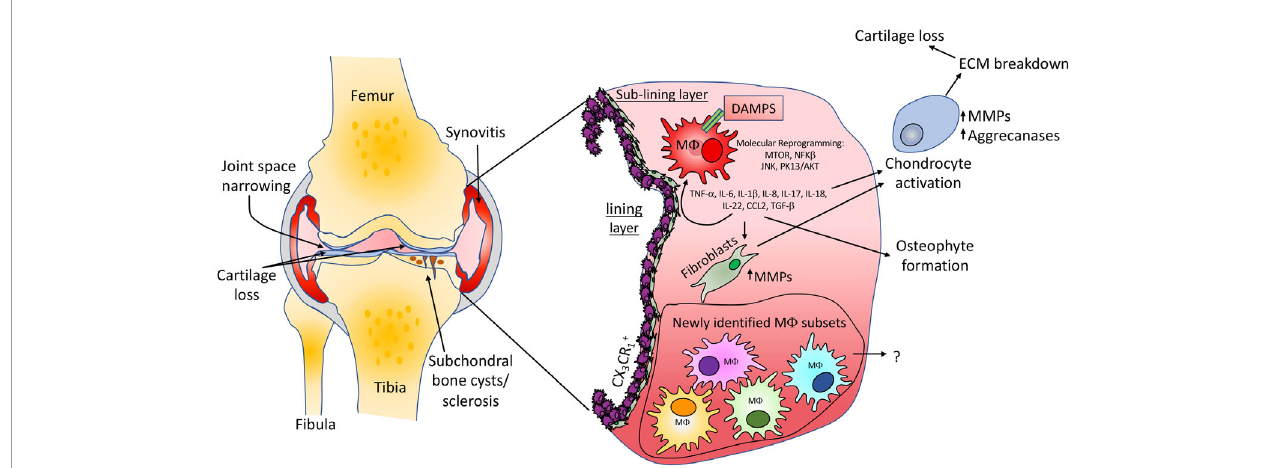
FIGURE 1 | Knee osteoarthritis pathology and macrophage involvement. Common features of OA including cartilage loss, narrowing of the joint space, synovitis and the development of subchondral bone cysts and sclerosis are shown. Macrophages in the synovium can contribute to OA via the release of in fl ammatory molecules which are able to stimulate resident fi broblast populations to produce cartilage extracellular matrix degrading enzymes. In fl ammatory molecules are also able to activate chondrocytes, promoting an abnormal molecular and cellular phenotype, again promoting cartilage loss. We suggest that the same or similar macrophage populations newly identi fi ed in in fl ammatory arthritis studies will be found in OA tissues, may differ between clinical states and could provide therapeutic targets for subgroups of patients. The identi fi cation and impact of such populations in OA development is yet to be